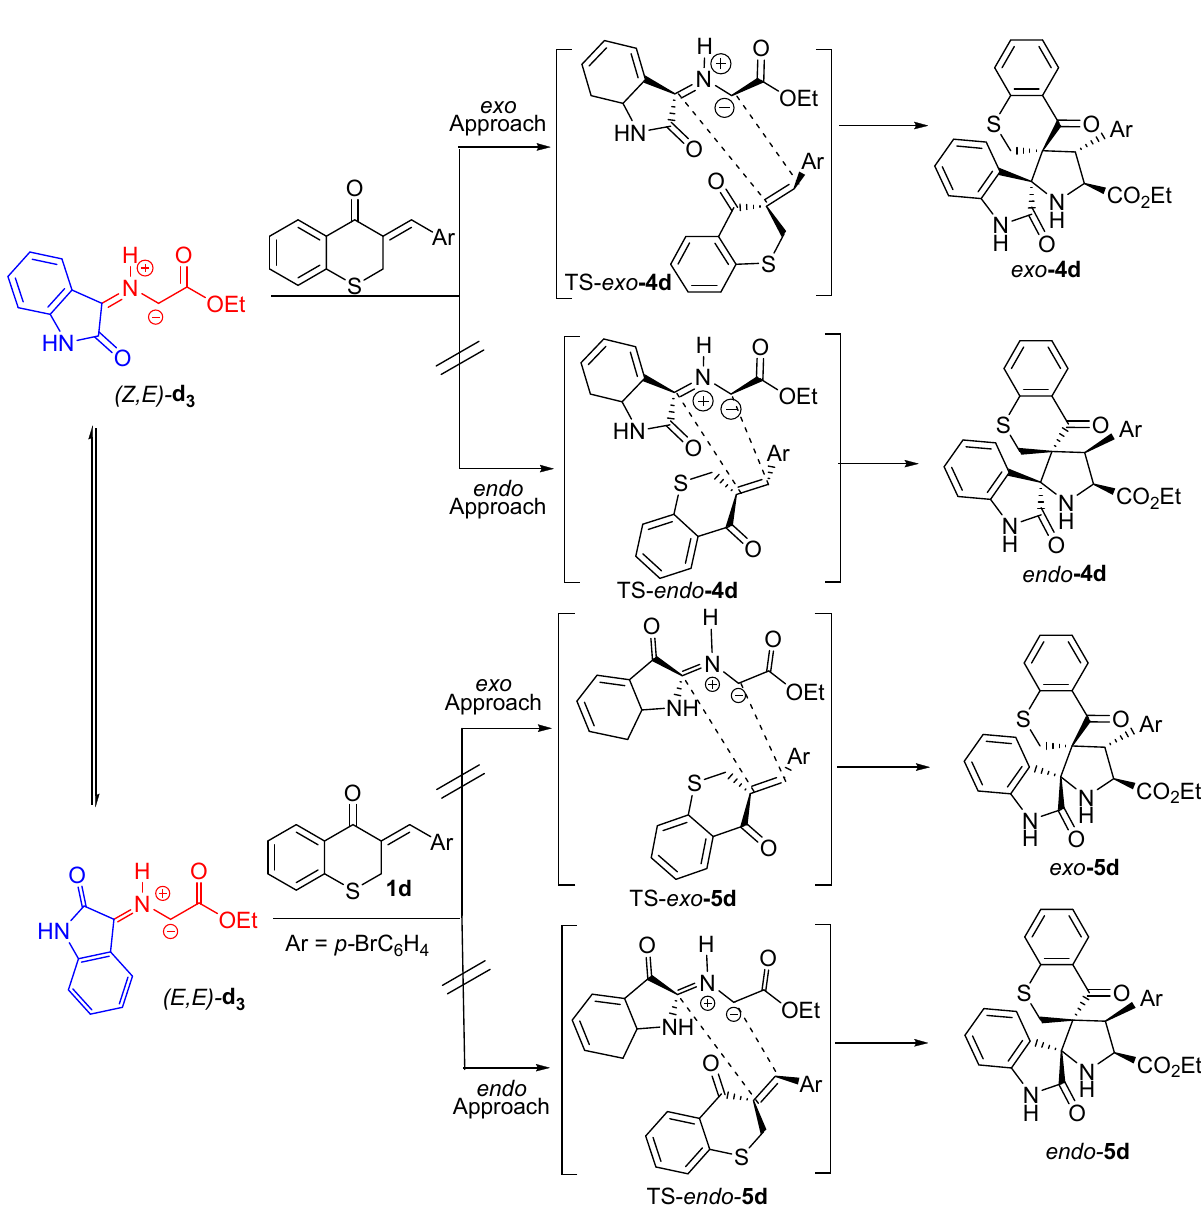
Scheme 2. Proposed mechanism for the regio- and stereoisomeric 1,3-dipolar cycloaddition reaction of dipolarophile 1d with azomethine ylide d